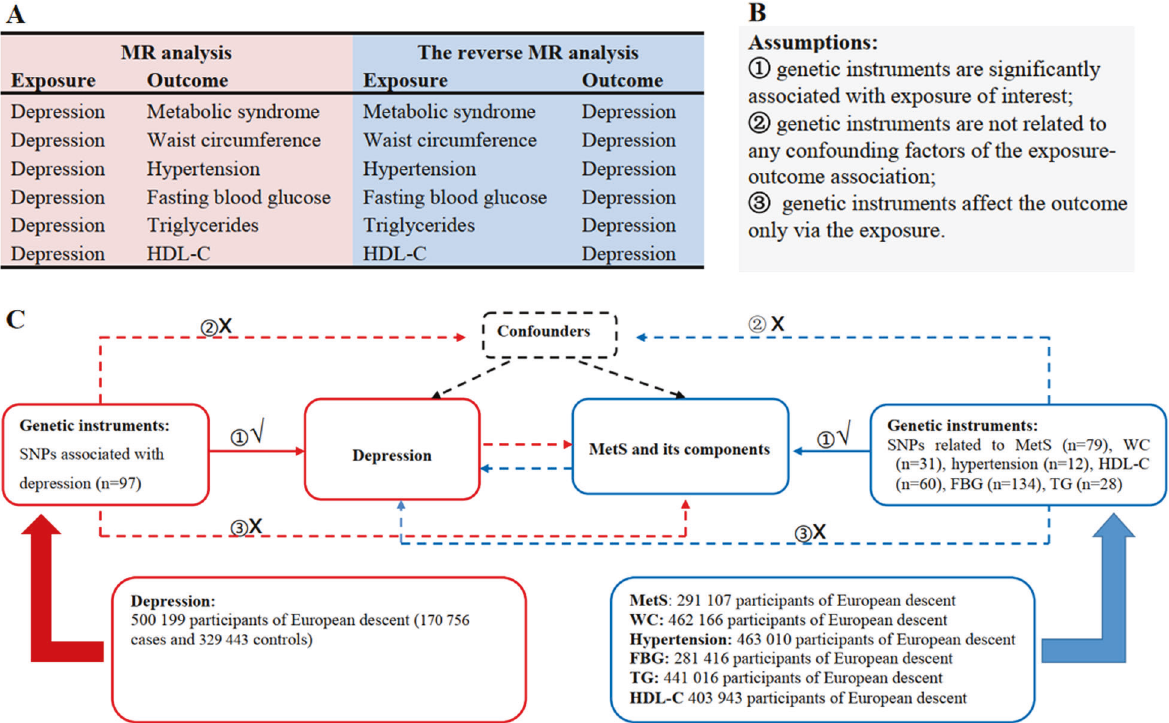
Fig. 1 Overview of the study design in this bidirectional MR study. A We performed a total of 12 MR analyses to investigate the bidirectional association between depression and MetS and its components. B MR analysis depends on three key assumptions. C Sketch of the study design. MetS metabolic syndrome, FBG fasting blood glucose, TG triglycerides, WC waist circumference, HDL-C high-density lipoprotein